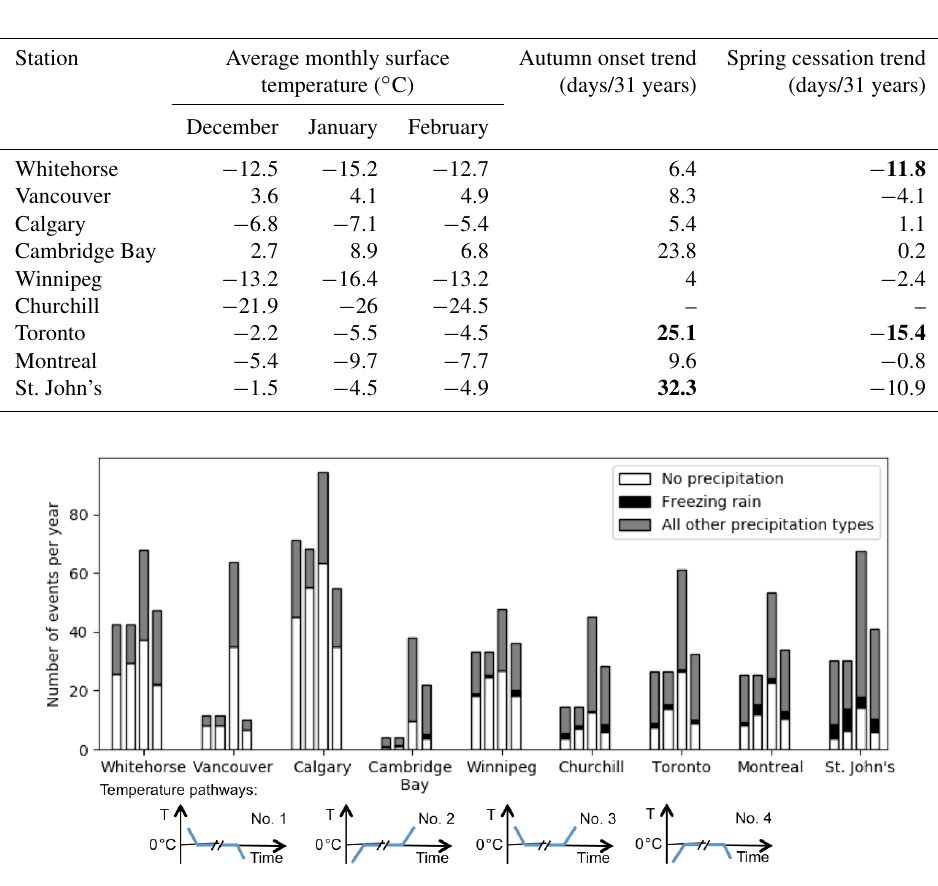
Figure 11. Average annual number of near-0 ◦ C events at the nine selected stations organized by surface temperature pathways. The four pathways are shown schematically below the figure. They are represented by bars at each station from pathway 1 to 4 (from left to right). No shading refers to the occurrence of near-0 ◦ C conditions, dark shading refers to the occurrence of freezing rain near 0 ◦ C, and light grey shading refers to the occurrence of all other types of precipitation near 0 ◦